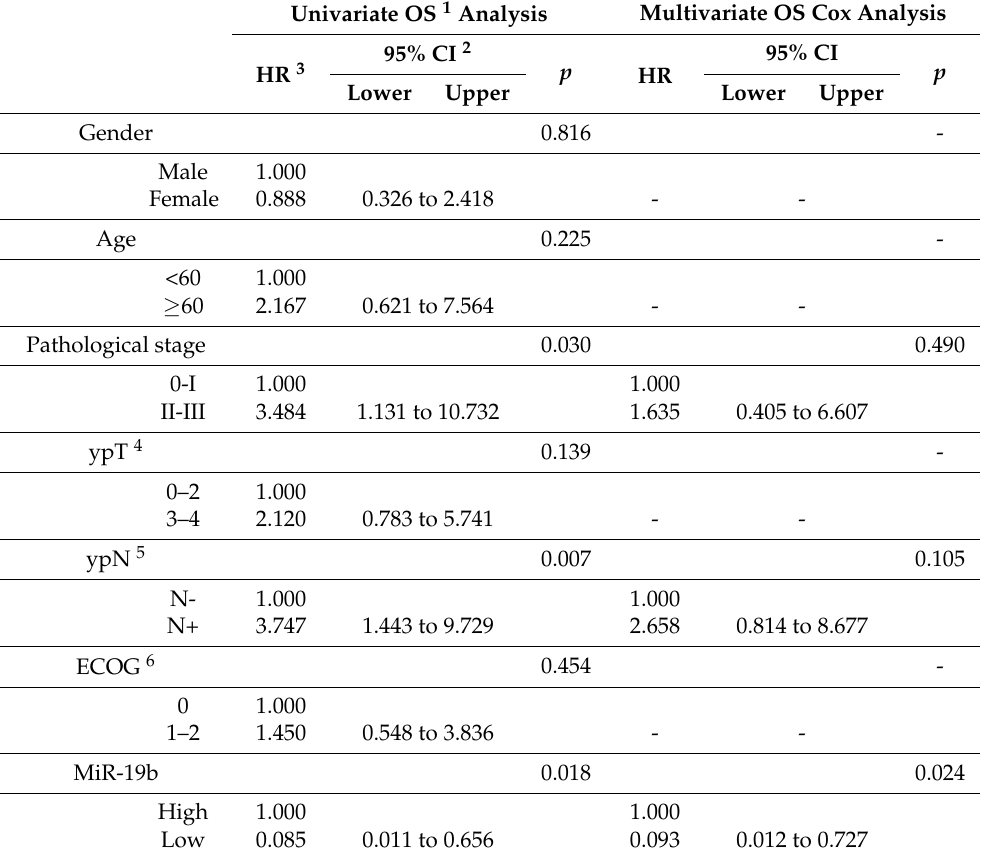
Table 5. Univariate and multivariate Cox analyses in the cohort of 121 LARC